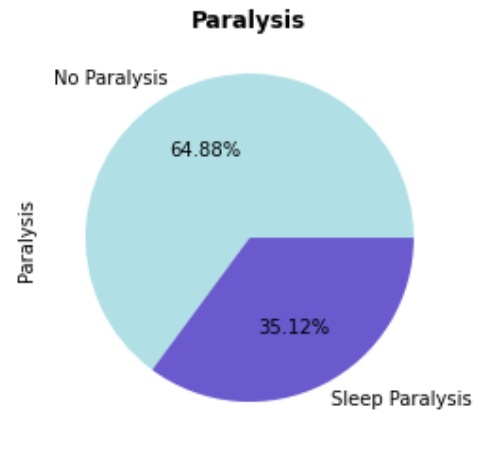
Figure 19. SVM Confusion Matrix with Polynomial Kernel